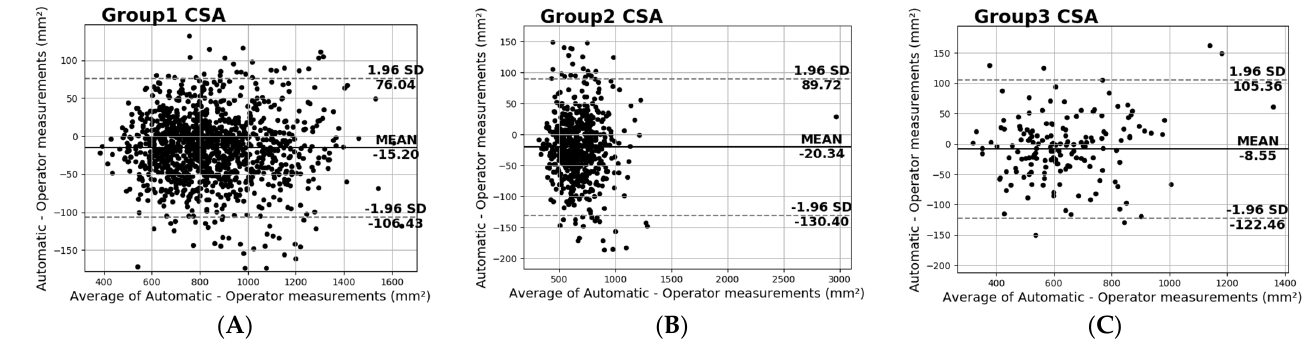
Figure 11. Bland − Altman plots of the CSA for ( A ) Group 1, ( B ) Group 2, and ( C ) Group 3.